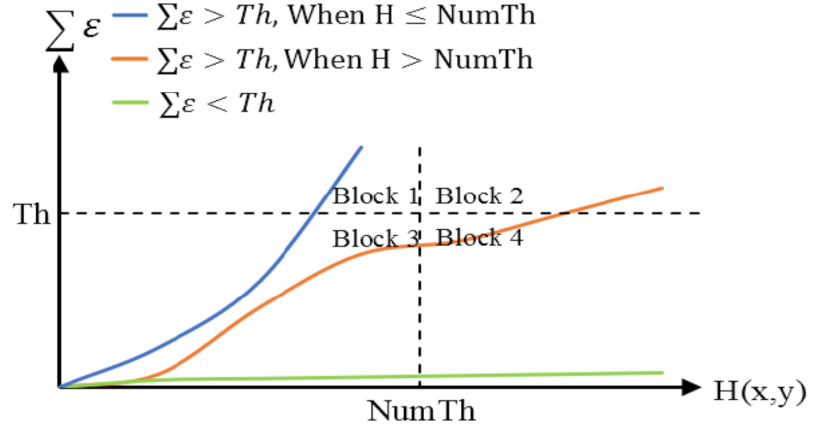
Figure 6. Illustration of the condition.